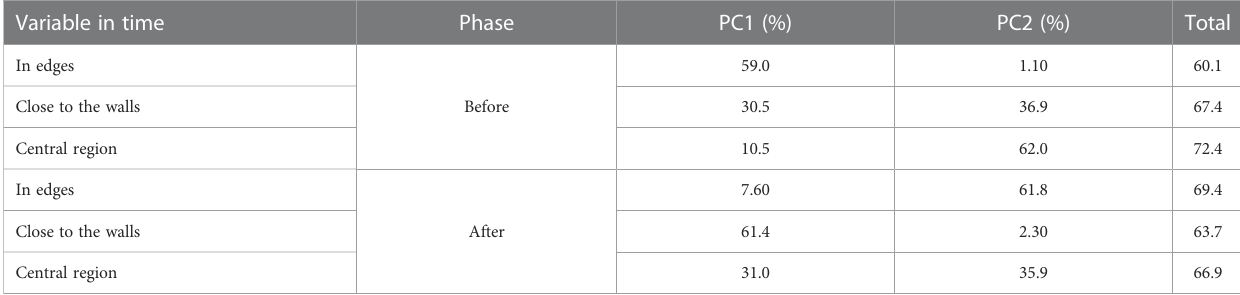
TABLE 3 Swine speci fi c oligonucleotide forward (F) and reverse (R) primer sequence (5 ’ -3 ’ ), amplicon length of the evaluated genes, and primer ef fi ciency in the standard curve on qPCR. Variable in